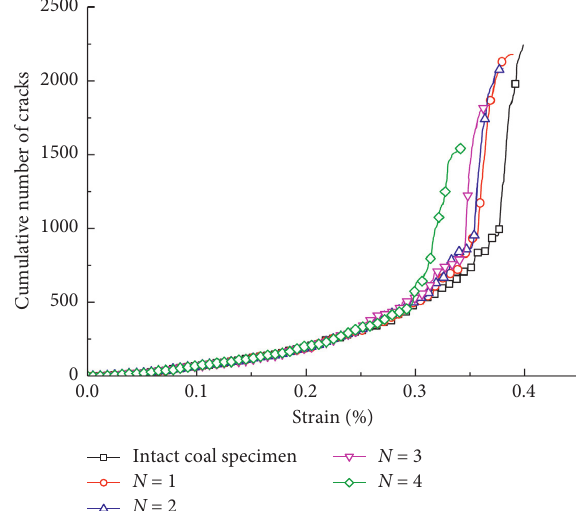
Figure 17: Curve of strain energy and strain.